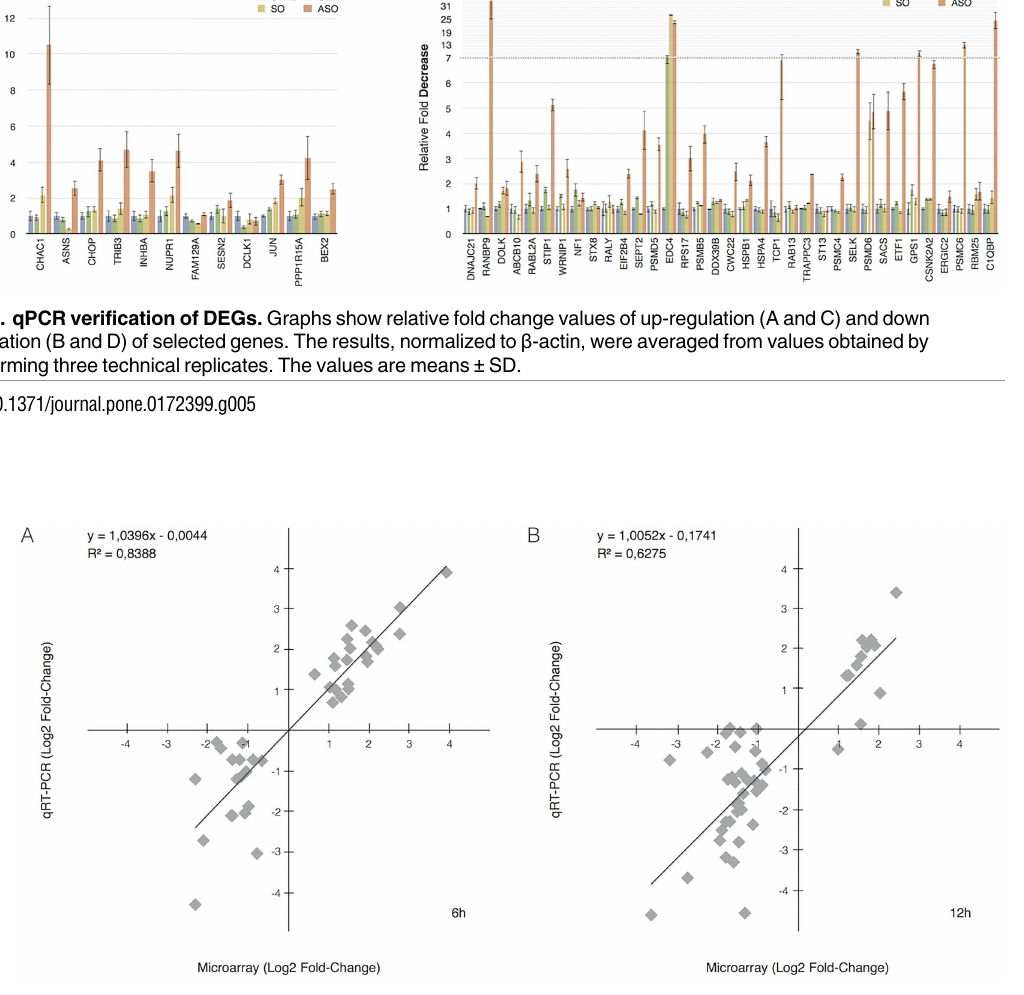
Fig 6. Validation of microarraydata with qRT-PCR. Correlation betweenqRT-PCR and microarray analysisat 6h (A) and 12h (B). The correlationcoefficients (R 2 ) are 0.83 and 0.62, respectively.